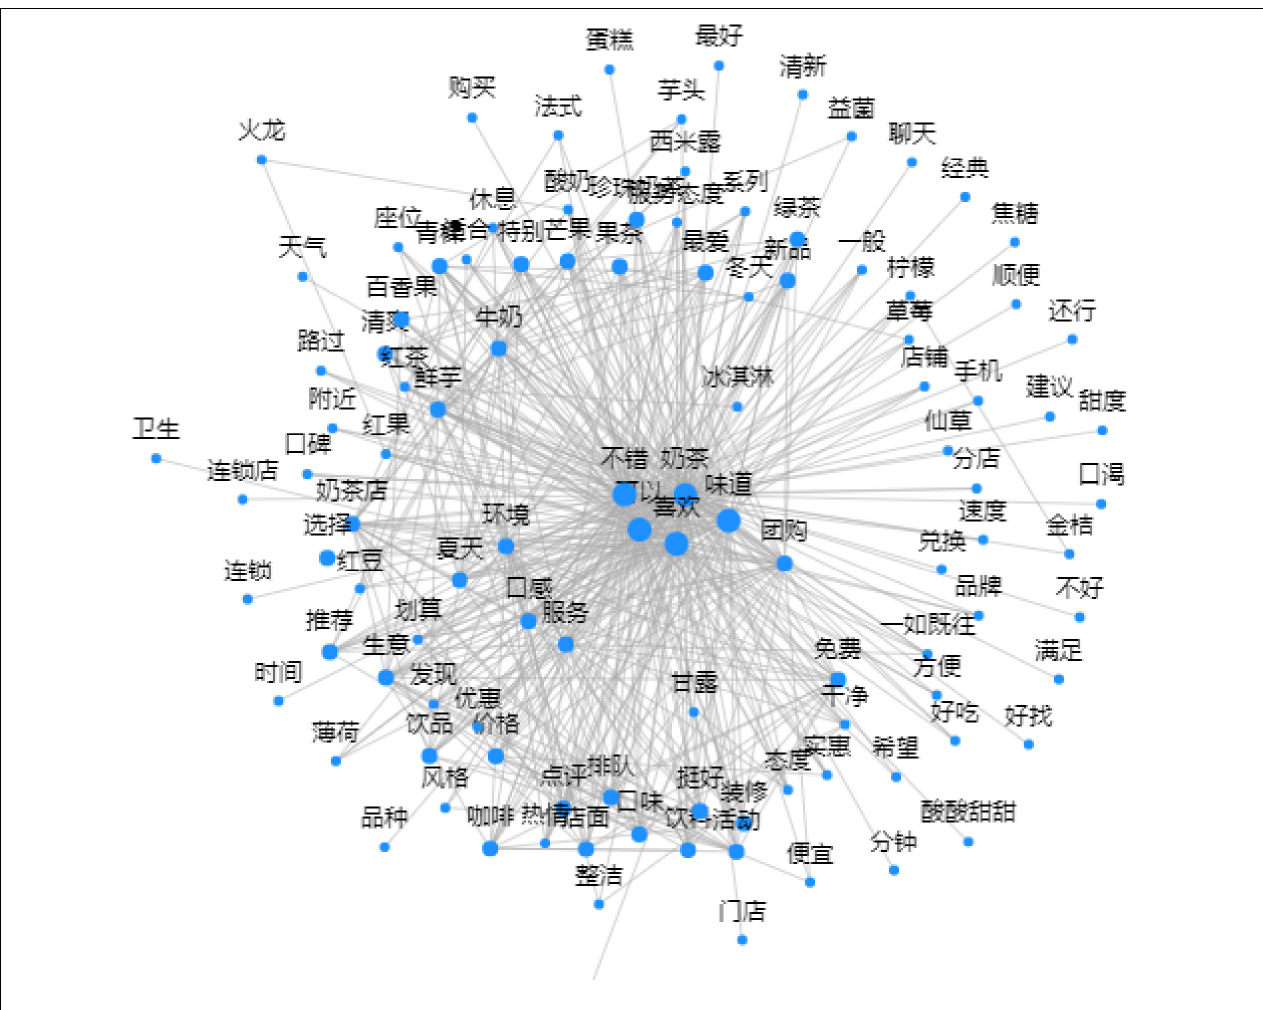
FIGURE 9 | Keywords social network map. TABLE 1 | Tag words classification and statistical